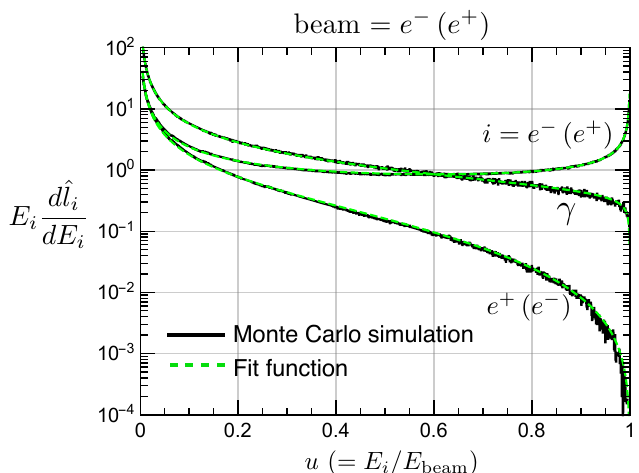
Figure 9. Normalized differential track lengths for particle i (= e − , e + , γ ) in a thick target ( & 10 X 0 ) induced by e − or e +